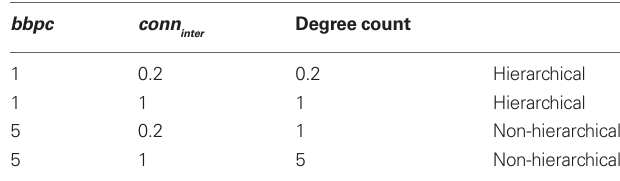
Table 2 | Network configurations tested for the effect of varying both intercluster connectivity conn and number of backbones per cluster inter bbpc . Degree count is calculated as the product of bbpc and conn inter